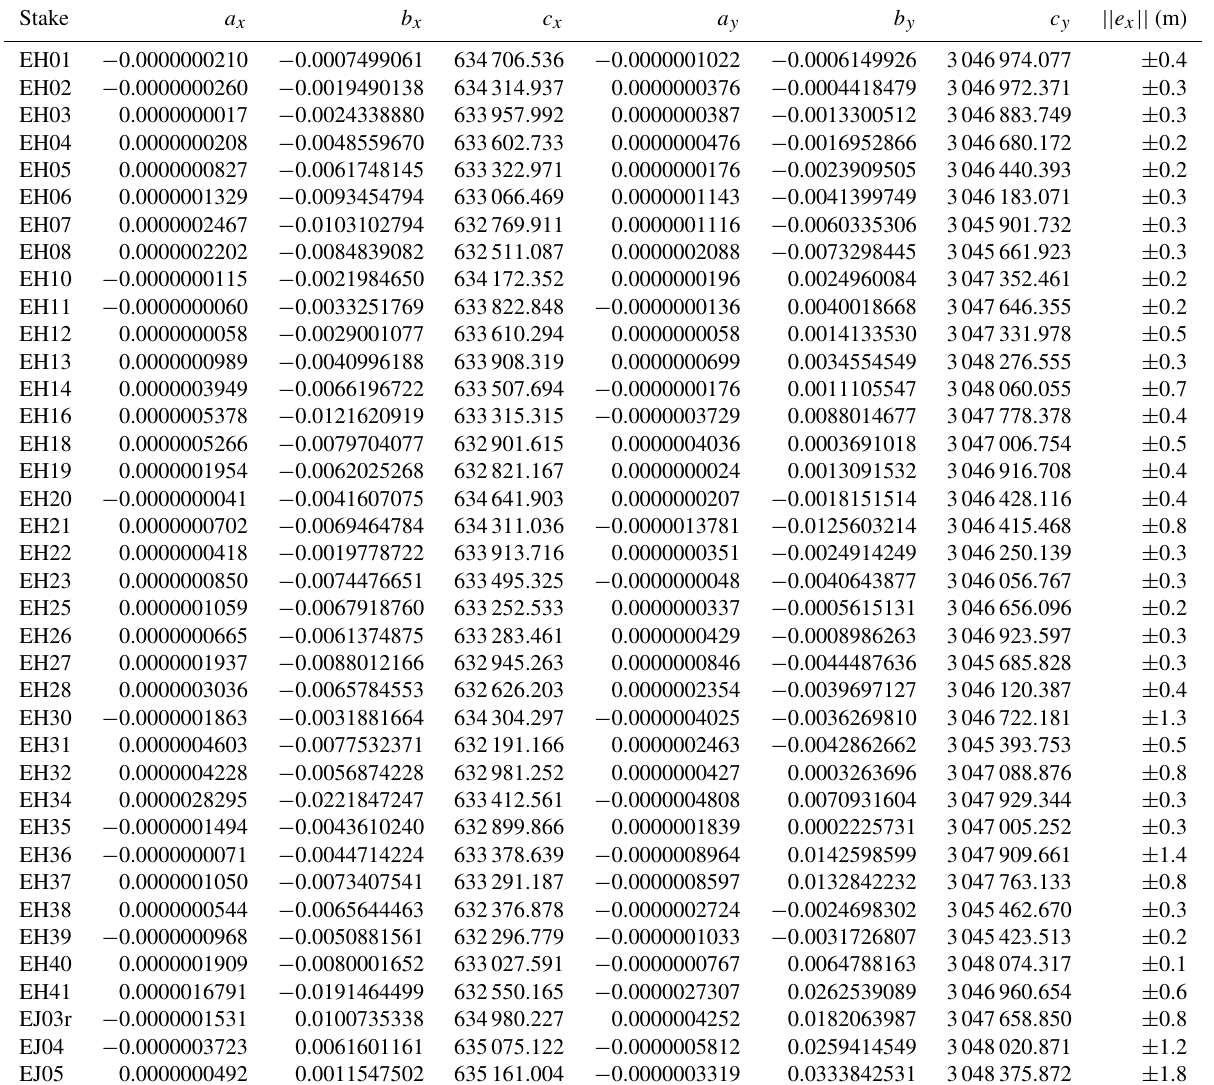
Table B1. Polynomial coefficients of the adjustment functions X a ( t i ) and Y a ( t i ), according to Eq. (2) for all the stakes of the glaciers under study. The units for the coefficients a , b , and c are myr − 2 , myr − 1 and m, respectively. The table also shows the estimated